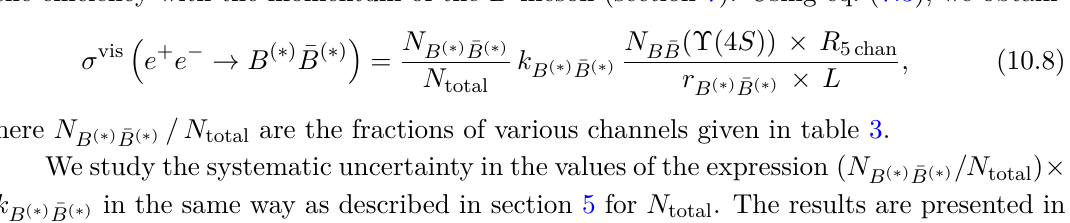
Table 7 . Systematic uncertainties in ( N / N total ) × k for various channels (in %). B ( ∗ ) ¯ B ( ∗ ) B ( ∗ ) ¯ B ( ∗ ) the ISR contribution down to the B ¯ B ∗ threshold, while the region between the B ¯ B and B ¯ B ∗ thresholds (the Υ(4 S ) region) is accounted for separately. For the B ¯ B ∗ and B ∗ ¯ B ∗ channels, k include the ISR contributions down to the corresponding thresholds. B ( ∗ ) ¯ B ( ∗ ) The efficiency ε is equal to ε × r , where the factor r = 1 . 010 , Υ(5 S ) B ( ∗ ) ¯ B ( ∗ ) B ( ∗ ) ¯ B ( ∗ ) B ( ∗ ) ¯ B ( ∗ ) 1.004, and 0.998 for B ¯ B , B ¯ B ∗ , and B ∗ ¯ B ∗ , respectively, accounts for the small variation of the efficiency with the momentum of the B meson (section 7). Using eq. (7.3), we